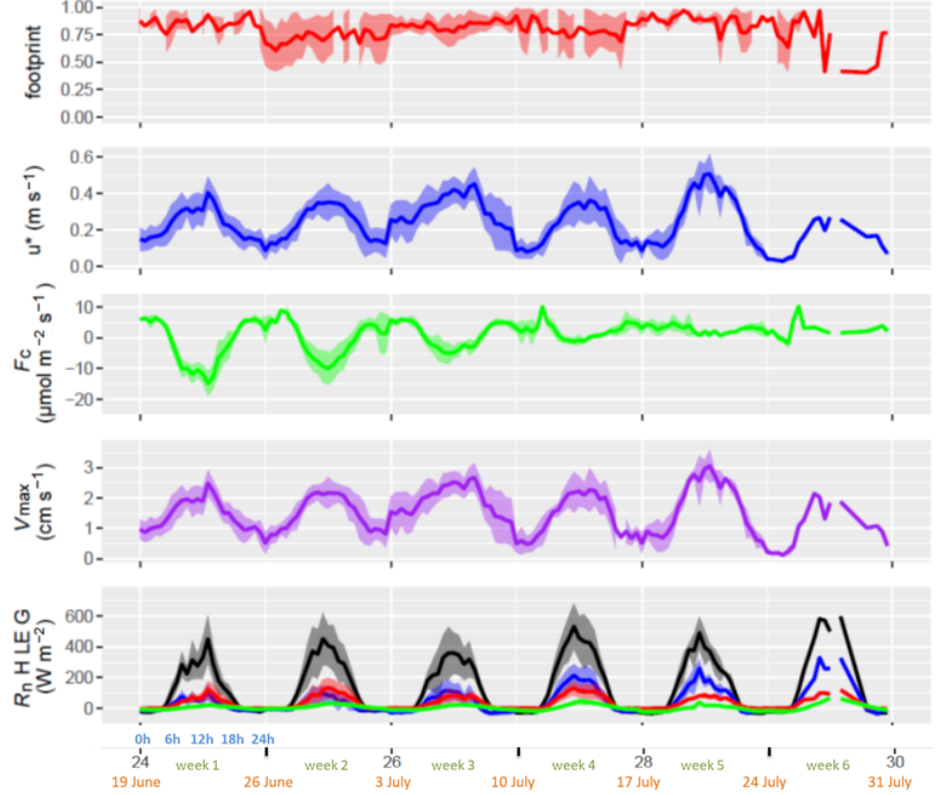
Figure 4. Field flux footprint, friction velocity ( u ∗ ), CO 2 flux ( F c ), maximum exchange velocity for water ( V max ) and terms of heat balance ( R n H LE G ): the net radiation ( R n , black), sensible heat flux ( H , blue), latent heat flux (LE, red) and ground heat flux ( G , green). By convention, except for R n and G , positive fluxes are ecosystem losses and negative fluxes are gains or uptakes. Each week shows the mean of diel cycles (lines) plus standard deviations (ribbons). The x axis shows the week number in the year (black), the week number within the experimental period (green), the starting date of the week (orange) and the hour of day